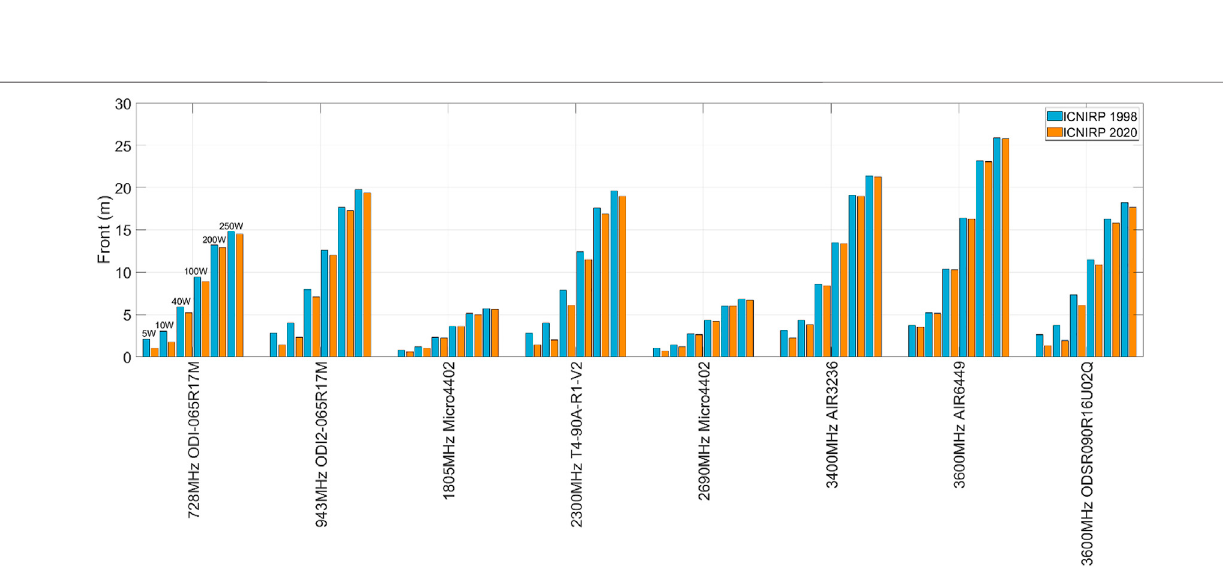
Frontiers in Communications and Networks |